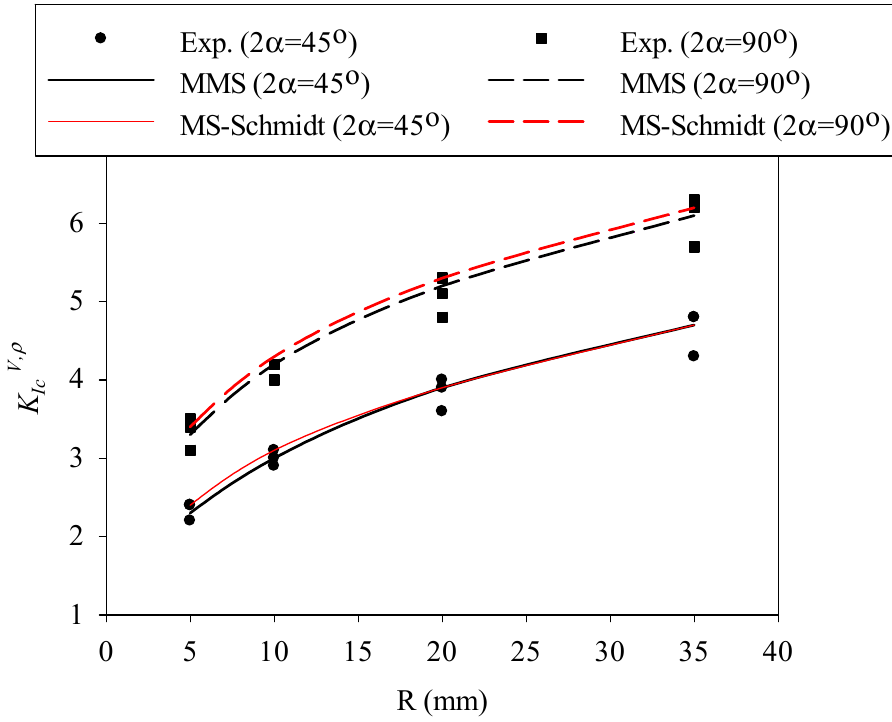
Figure 9. Variation in K IcV, ρ with specimen size for RVNSCB specimens made of PMMA. Predictions provided by the MS–Schmidt and the MMS criteria, and experimental data.